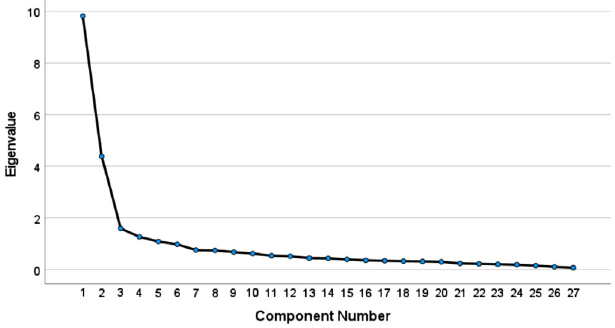
FIG. 2. Scree plot of